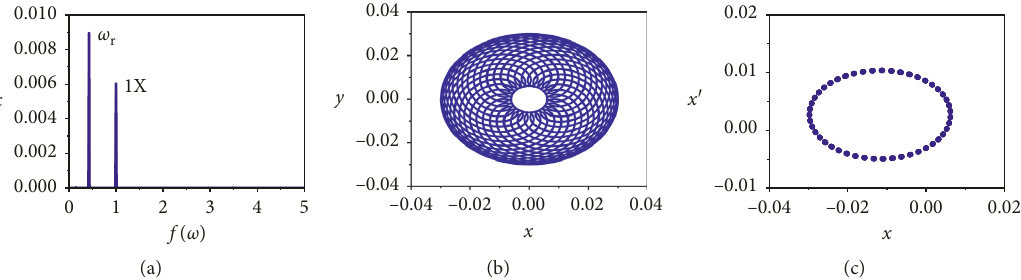
Figure 5: The quasiperiodic response of the rotor/seal system at s rotor. (c) The Poincar´e map of the x coordinate.